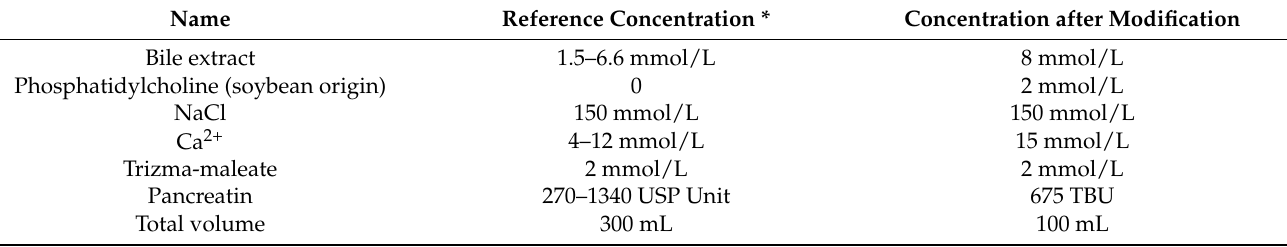
Table 1. The initial compositions of the simulated intestinal